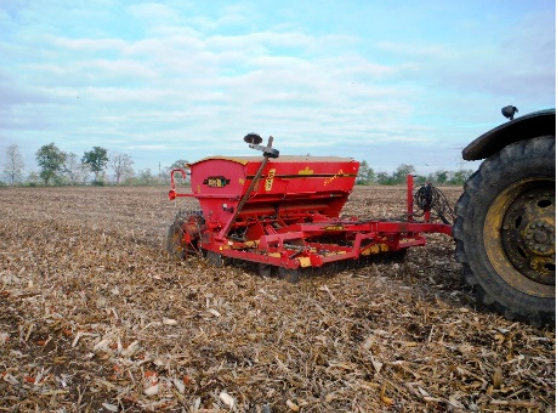
Figure 2. Direct drilling (no-till farming) at JTEF (Source: Igor Dekemati).